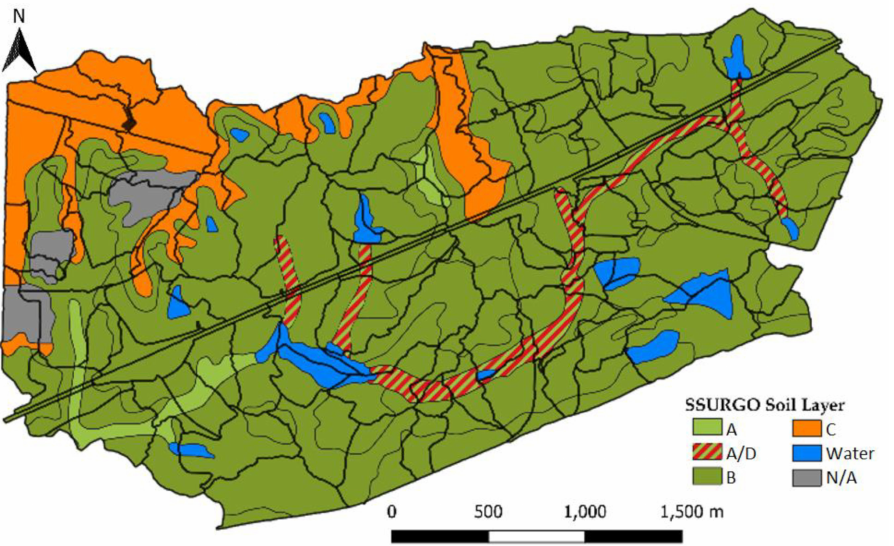
Figure 3. SSURGO Soil Layer map of selected research area at the Moore’s Mill Creek